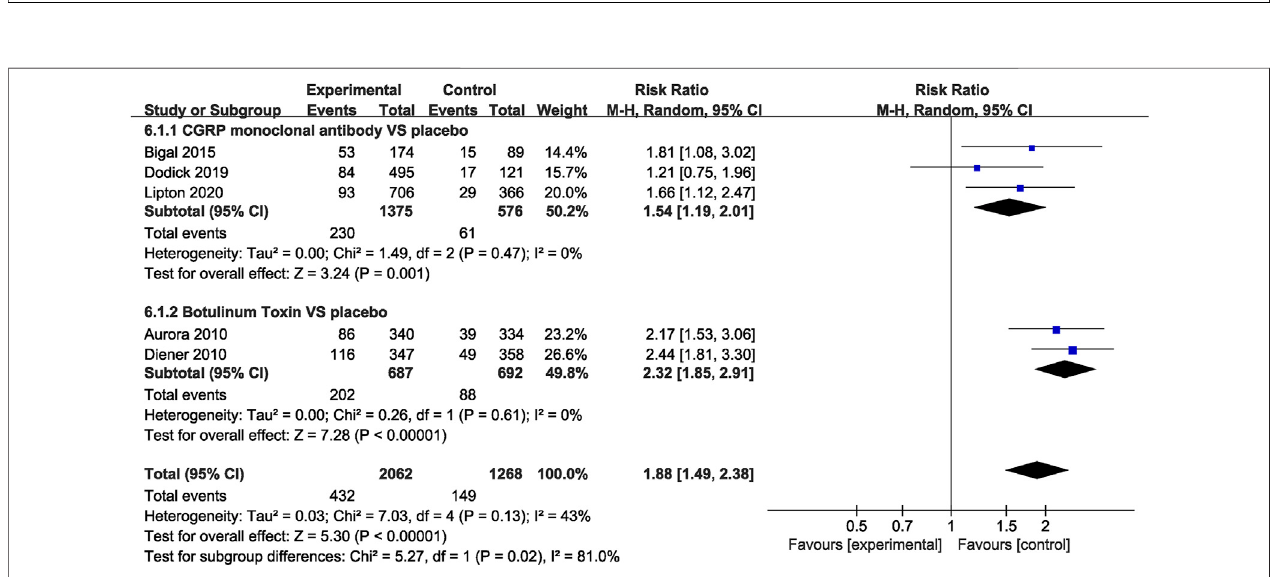
FIGURE 8 | Comparison of treatment-related AEs in CGRP monoclonal antibody vs. placebo and botulinum toxin vs. placebo.